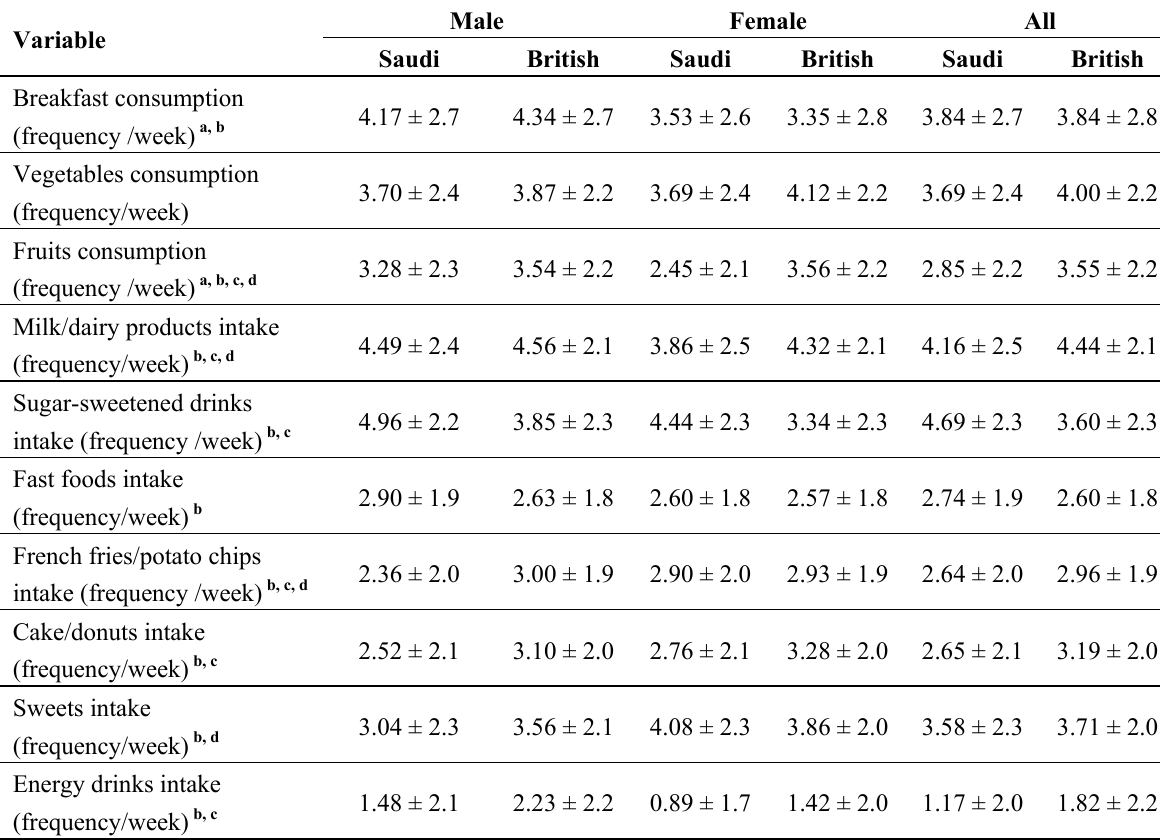
Table 5. Dietary habits of Saudi and British